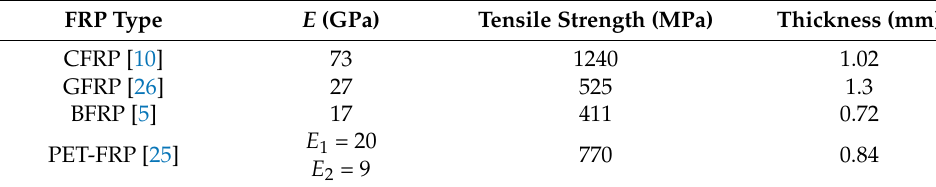
Figure 6. Failure mode of a slab specimen strengthened with one CFRP layer: ( a ) Experiment [10]; ( b ) FE model. Table 2. Mechanical properties of the investigated FRP laminates.